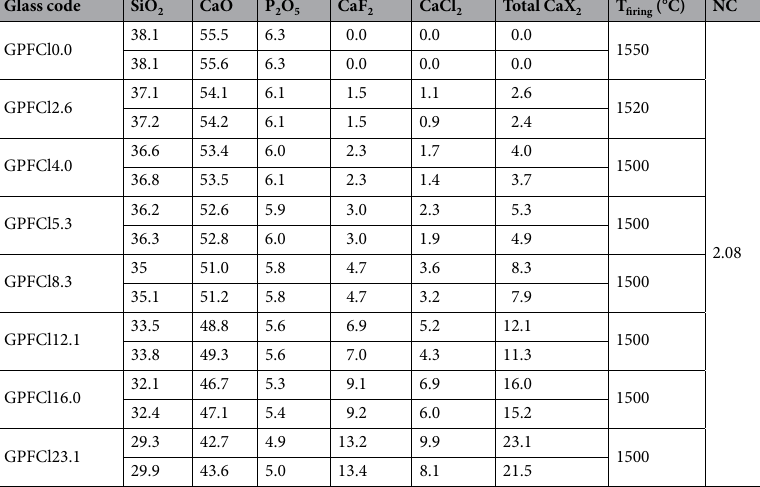
rotor and spun at 6 kHz with a relaxation time of 300 s delay for 432 scans and a pulse duration of 4.0 μ s. The